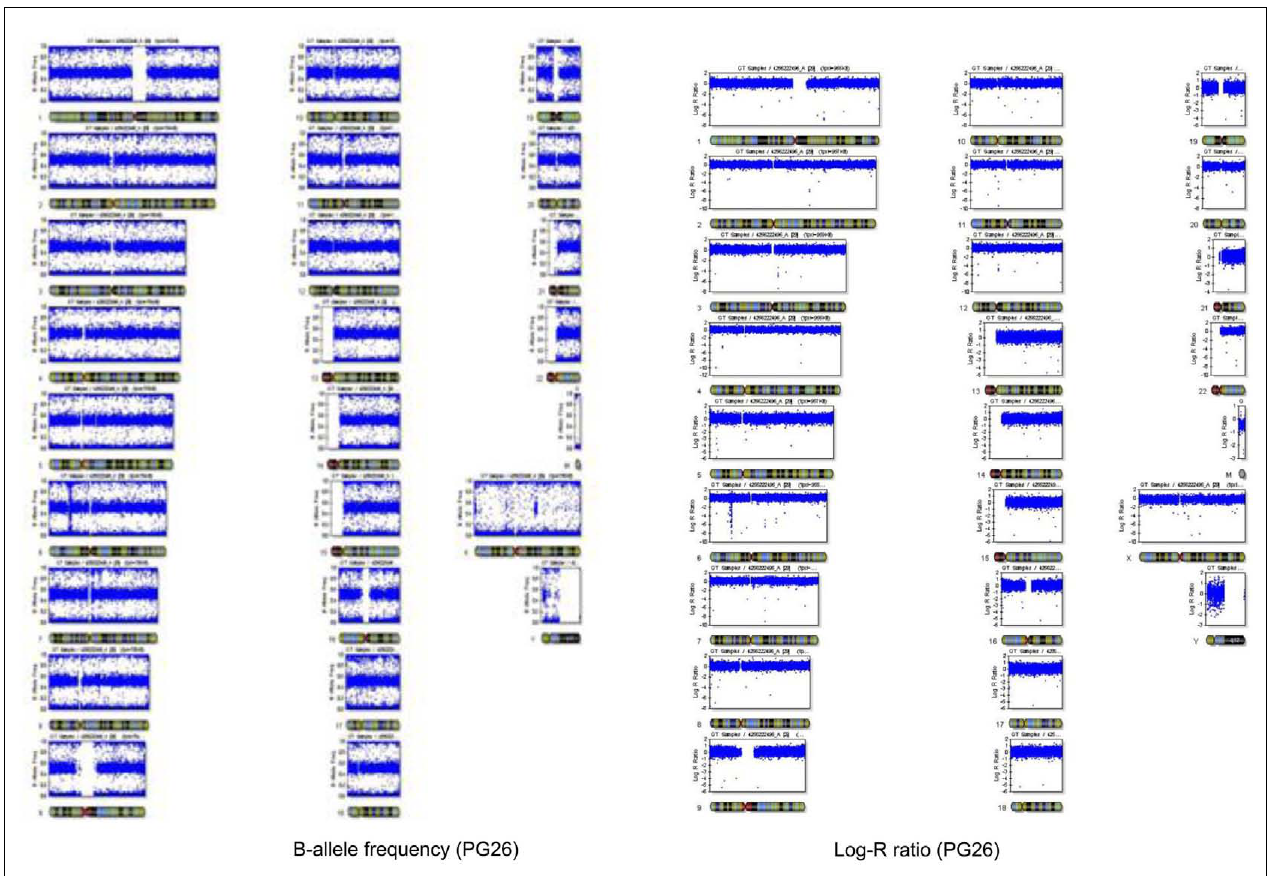
FIGUREA4 | Plot of the B allele frequency and the log R ratio in PG26. The plot of B allele frequency shows that there are no large structural